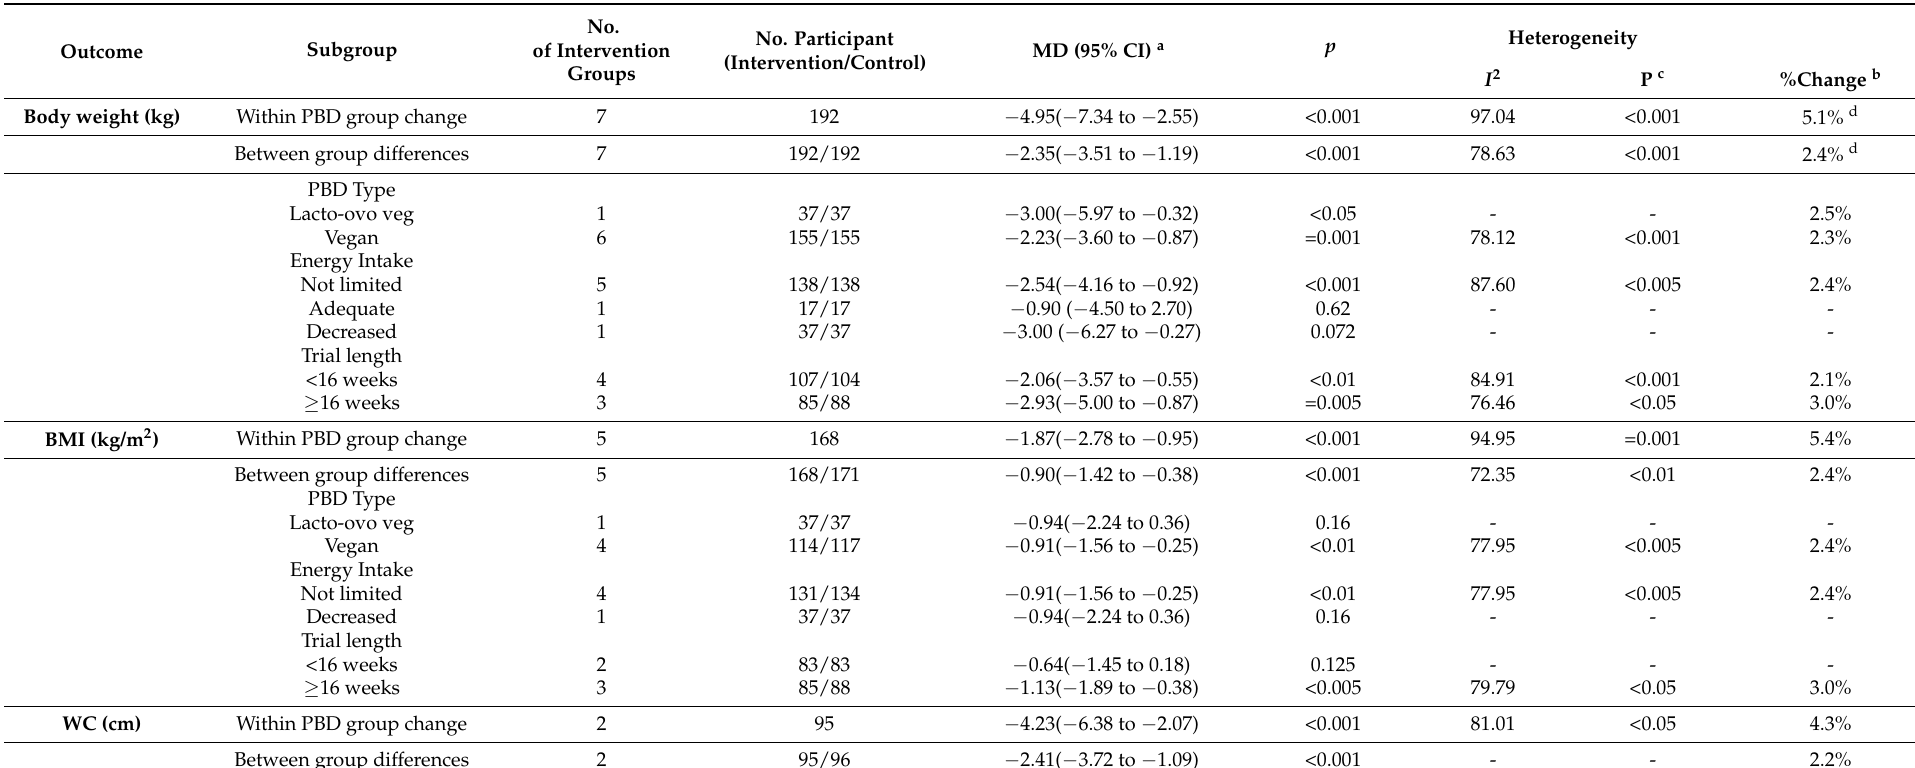
Table 3. Pooled summary effects and sub-group analysis of PBDs on body weight, BMI, and